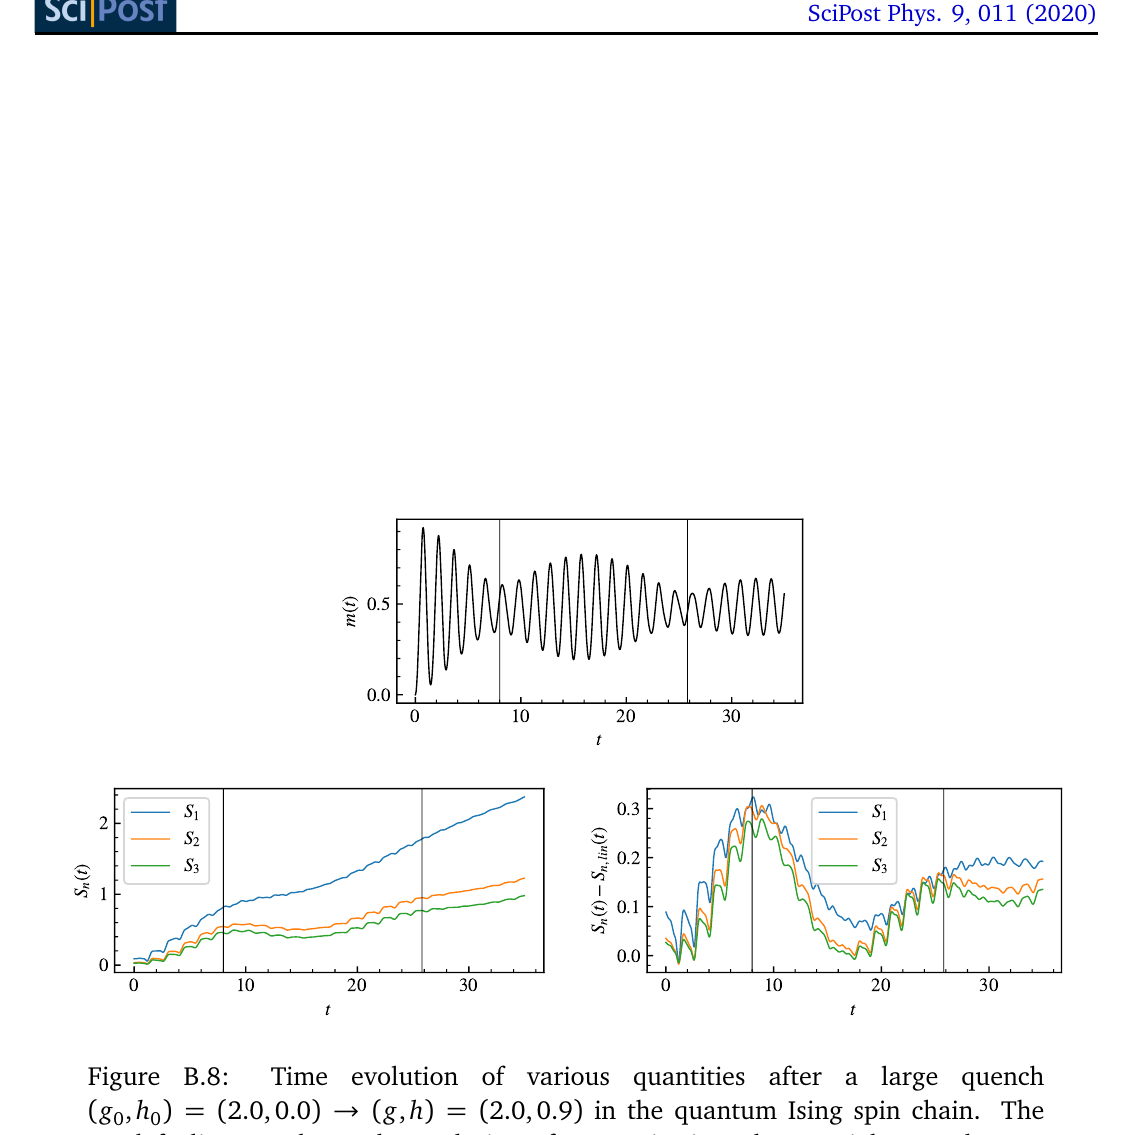
and S ), while the bottom 2 3